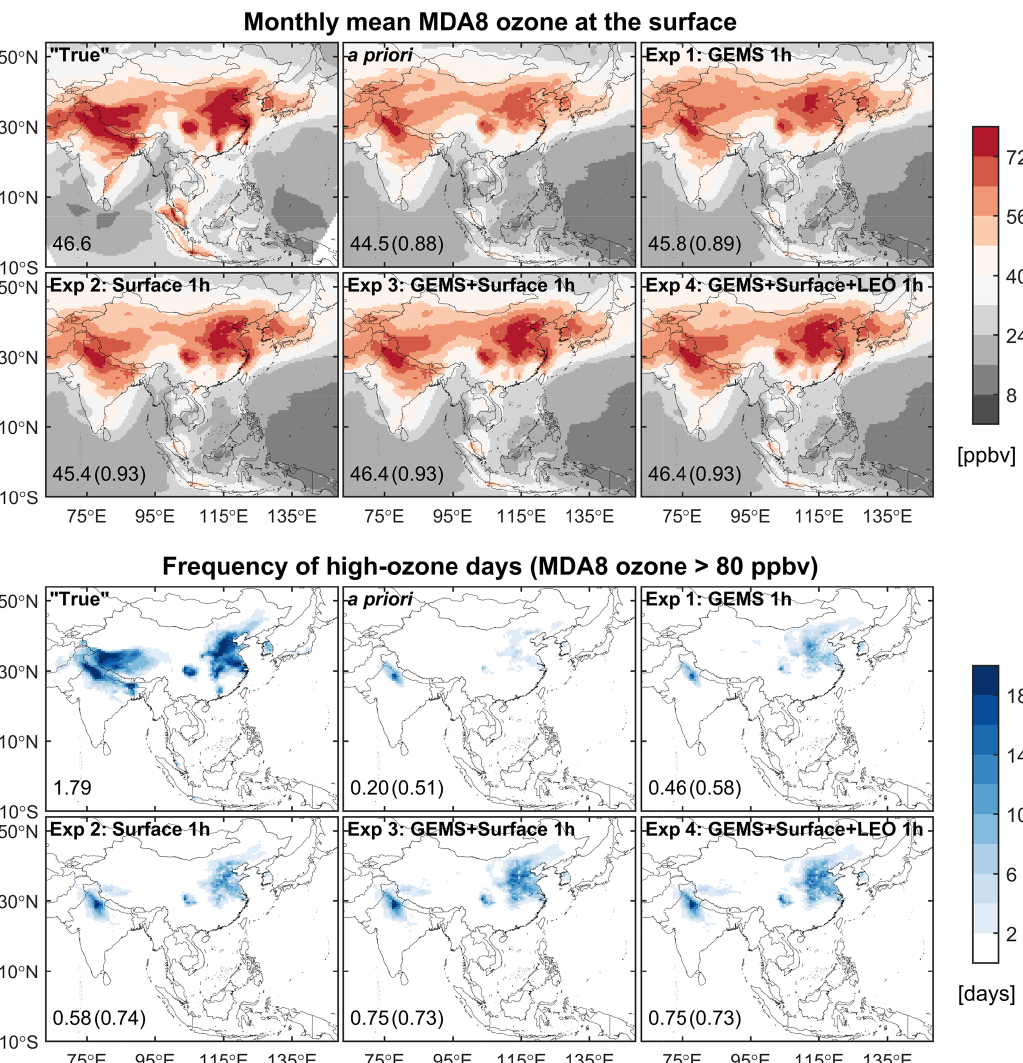
Figure 4. Monthly mean daily maximum 8h average (MDA8) ozone at the surface and the frequency of high-ozone days (defined as surface MDA8 ozone exceeding 80ppbv) for June 2020 over the Asian domain, as simulated by the nature run (“True”), the control run (a priori), and four assimilation runs (Exp 1–4 in Table 1). The domain-averaged value over the land is inset. For the control run and assimilation runs, the spatial correlation coefficients relative to the nature run are also inset in